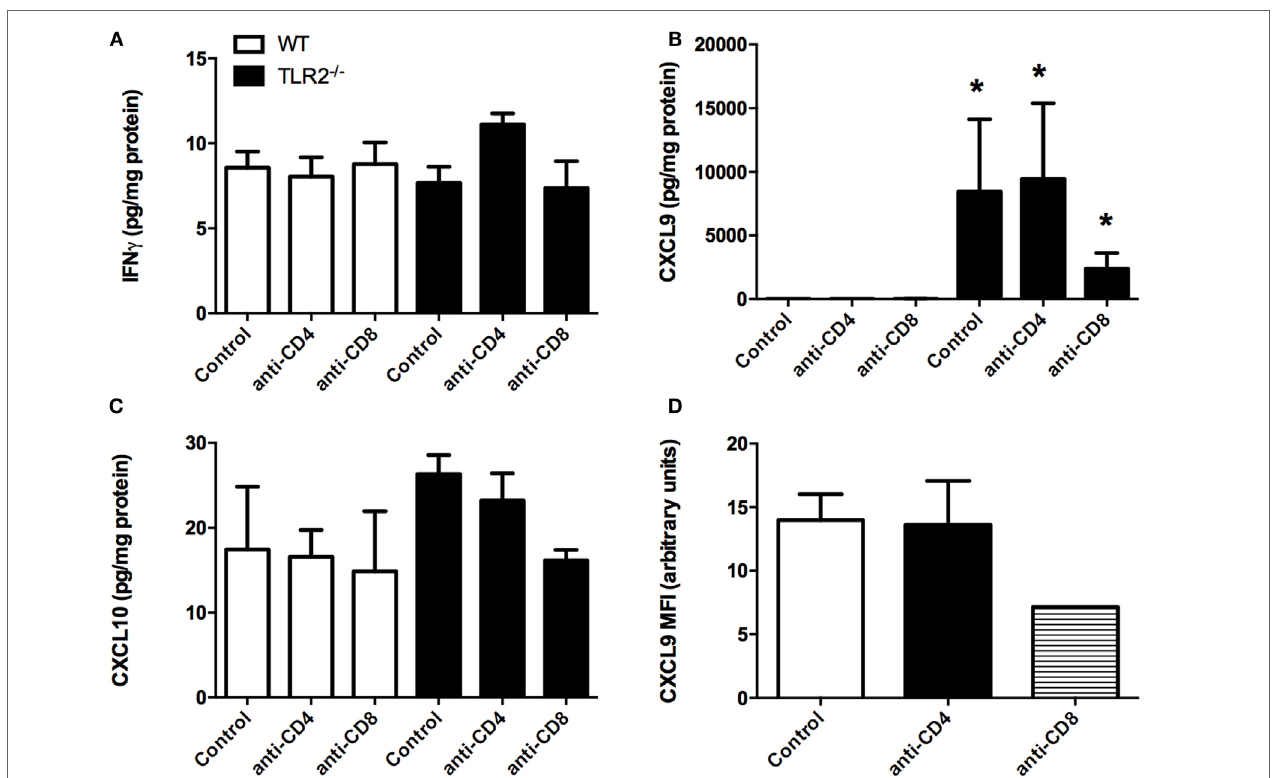
FigUre 8 | cytokine production in joints of infected mice . Mice were infected and treated as in Figure 4 . On day 21 postinfection, the mice were sacrificed and levels of IFN γ (a) , CXCL9 (B) , and CXCL10 (c) were determined from homogenized joint tissue using a Lumina assay. CXCL9 levels within ICAM-1 + VCAM- 1 + CD14 − synoviocytes were assessed from TLR2 − / − mice at 14 days postinfection by flow cytometry (D) . n = 3, data representative of one trial. Bars represent means ± SD. * p > 0.01 compared to WT